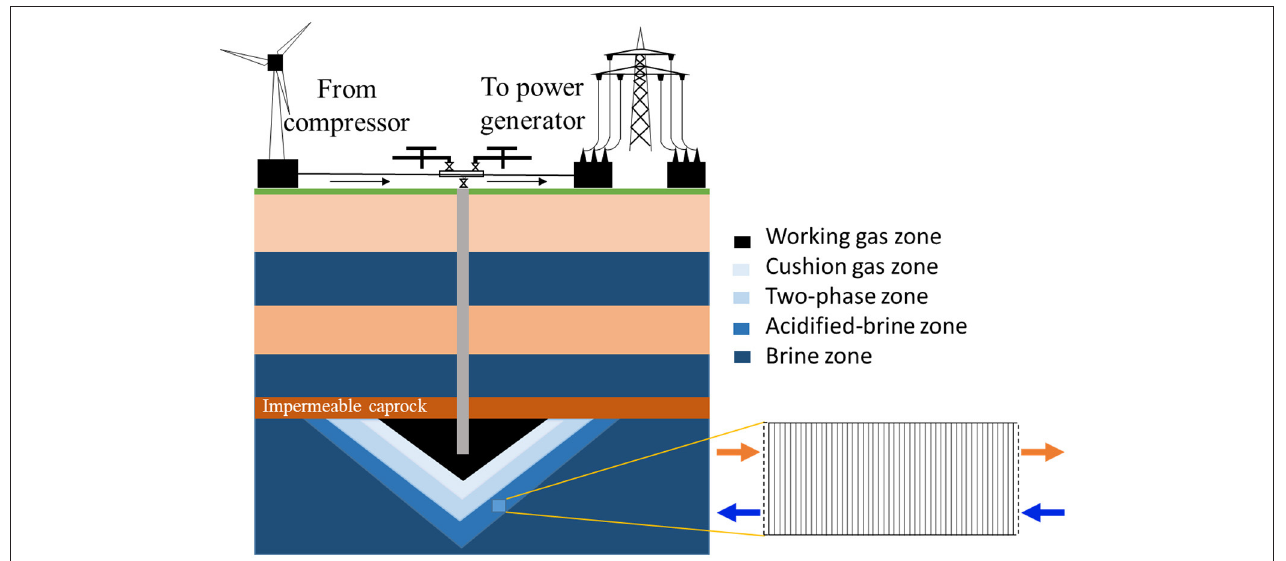
FIGURE 1 | Schematic of the energy storage system and model domain for the reactive transport simulations. The “two-phase zone” corresponds to the presence of brine and cushion gas.